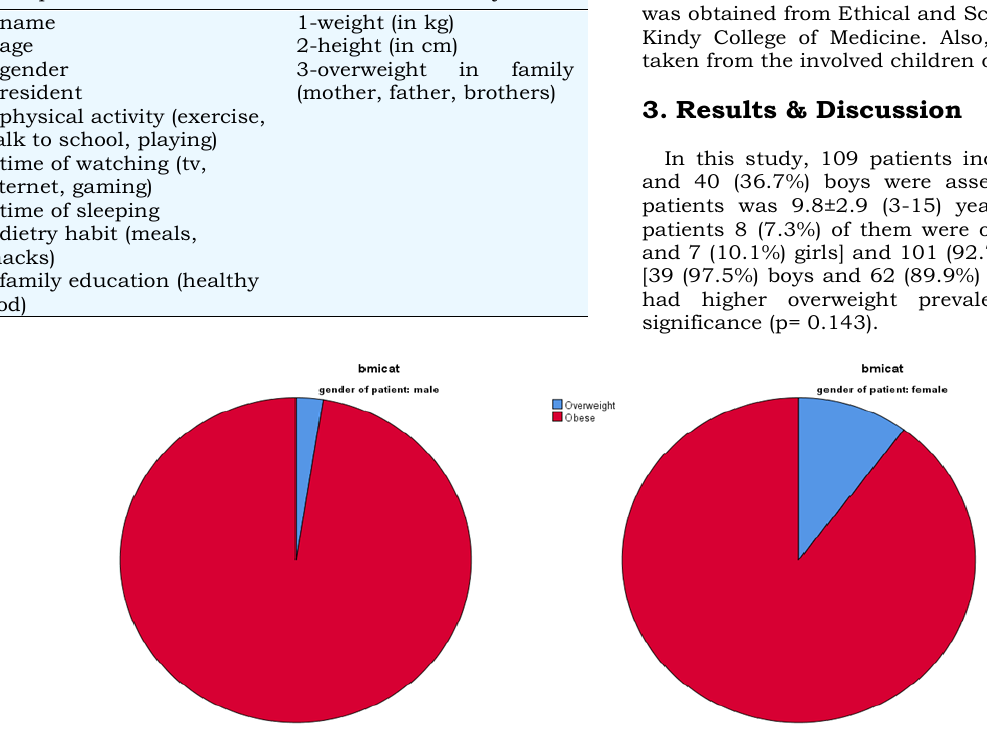
Fig. 1. prevalence of overweight and obesity in both male (in the left) and female (in the right) Table (2) demonstrates the correlation between BMI and physical activity, watching TV, sleep hours and